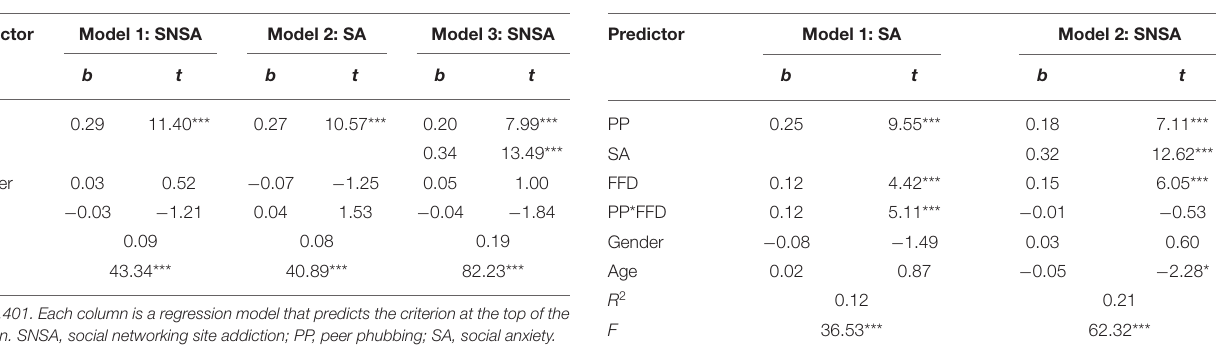
FFD, family financial difficulty; PP * FFD, interaction of peer phubbing and family financial